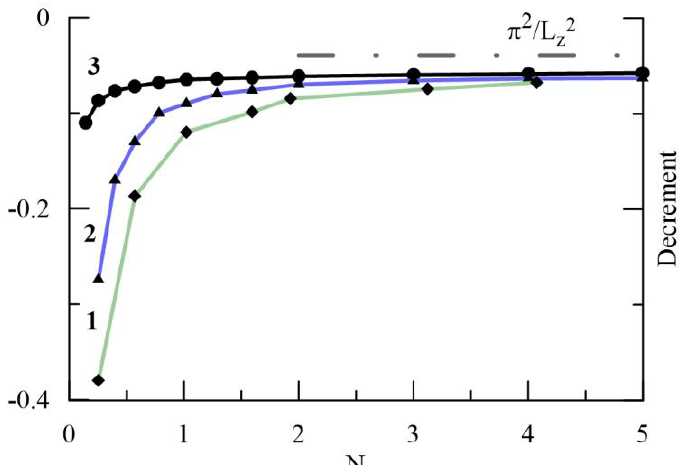
Fig. 5. Dependence of the decrements of the higher-frequency (1), lower-frequency anti-symmetric (2) and symmetric (3) modes of the Bragg resonator on the Fresnel parameter N . Dot-dashed line denotes the asymptotic values determined by relation (10).